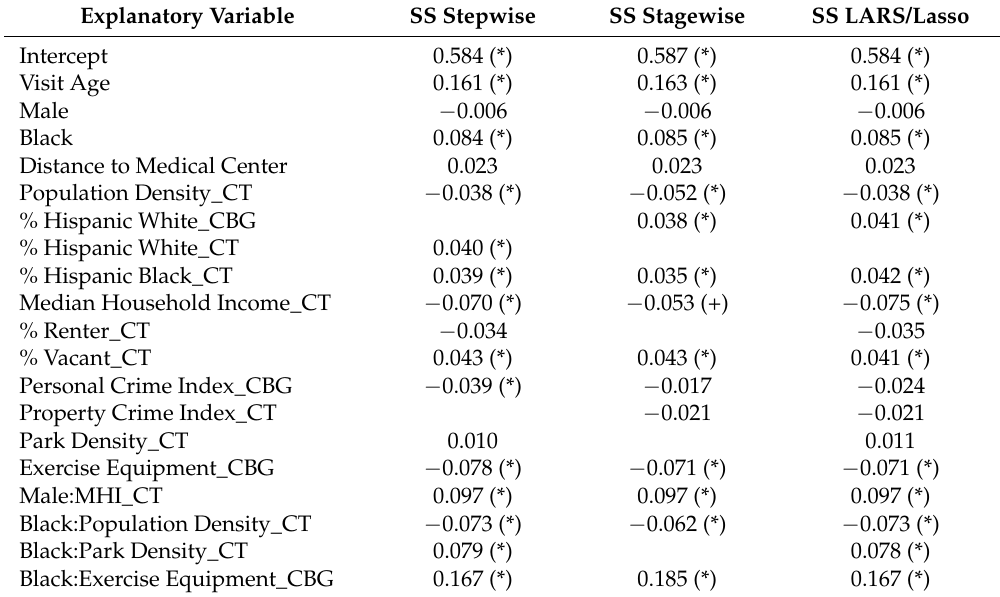
Table 12. Standardized coefficient estimates when the covariate male, select interaction terms, and covariates selected by the spatial scale (SS) forward stepwise, forward stagewise, and LARS/lasso algorithms were plugged into OLS regression models of BMI z-scores. The blank cells indicate variables not selected for a particular model. The horizontal dashed line separates the individual-level variables and the neighborhood-level variables considered at multiple spatial scales. Explanatory Variable SS Stepwise SS Stagewise SS LARS/Lasso 0.584 (*)